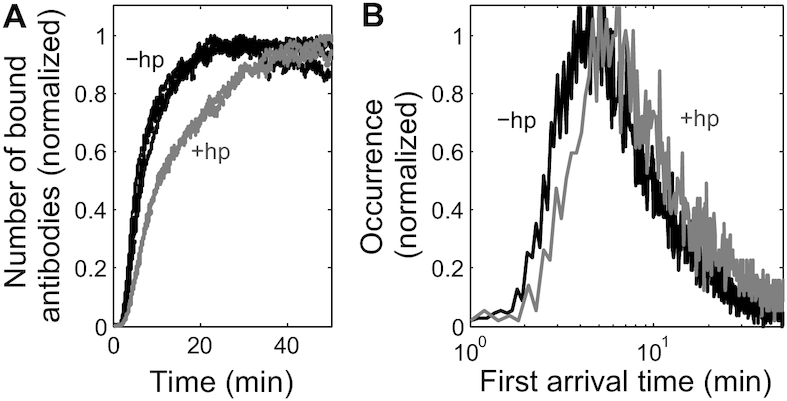
A small hairpin structure in the 5′ UTR of 3xFLAG-Fluc mRNA slows initiation. (A) Time courses of the number of antibody binding in YE translation of 3xFLAG-Fluc (black; 3 data sets) and hp-3xFLAG-Fluc (gray; 2 data sets) mRNAs, respectively. The three black data sets and two gray data sets overlay significantly within each group, indicating the robustness of this measurement. (B) The corresponding first arrival time histograms of the experiments in (A). The multiple data sets for each mRNA from (A) were pooled together in (B). n = 10 650 trajectories for -hp mRNA and 4079 trajectories for +hp mRNA. The x-axis is in log scale for better visualization of the difference in first arrival time between the two mRNAs. Both histograms fit well to the shifted (3-parameter) log-normal distribution (Equation 1, Supplementary Figure S6, and Supplementary Table S1).